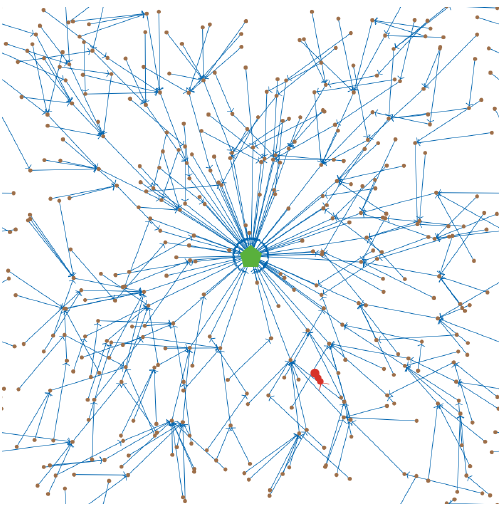
Figure 5. Network instance.